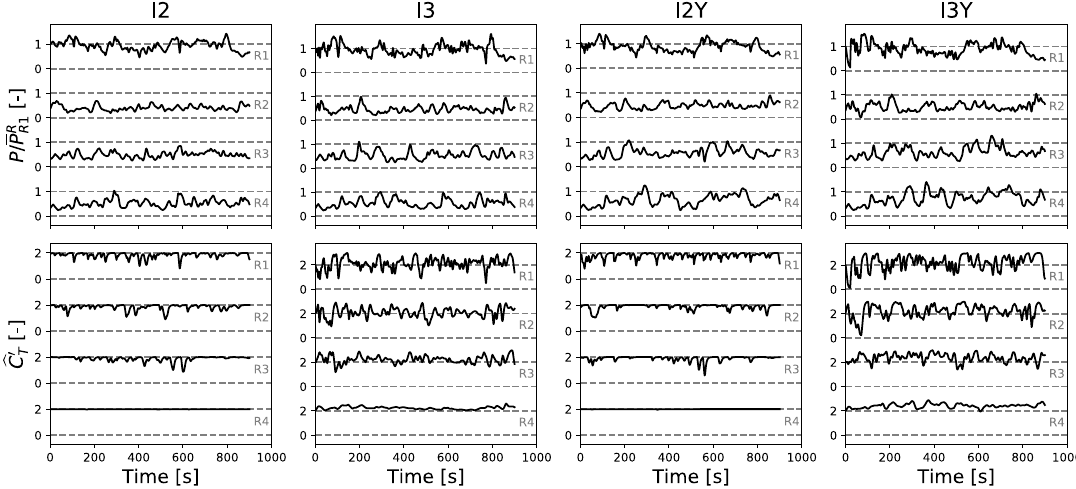
Figure 16. Time evolution of column C1 in turbulent inflow induction-enabled cases. Top: Turbine power extraction P , normalized by mean first row power in the uncontrolled reference P Bottom: Thrust coefficient (cid:98) C (cid:48) T